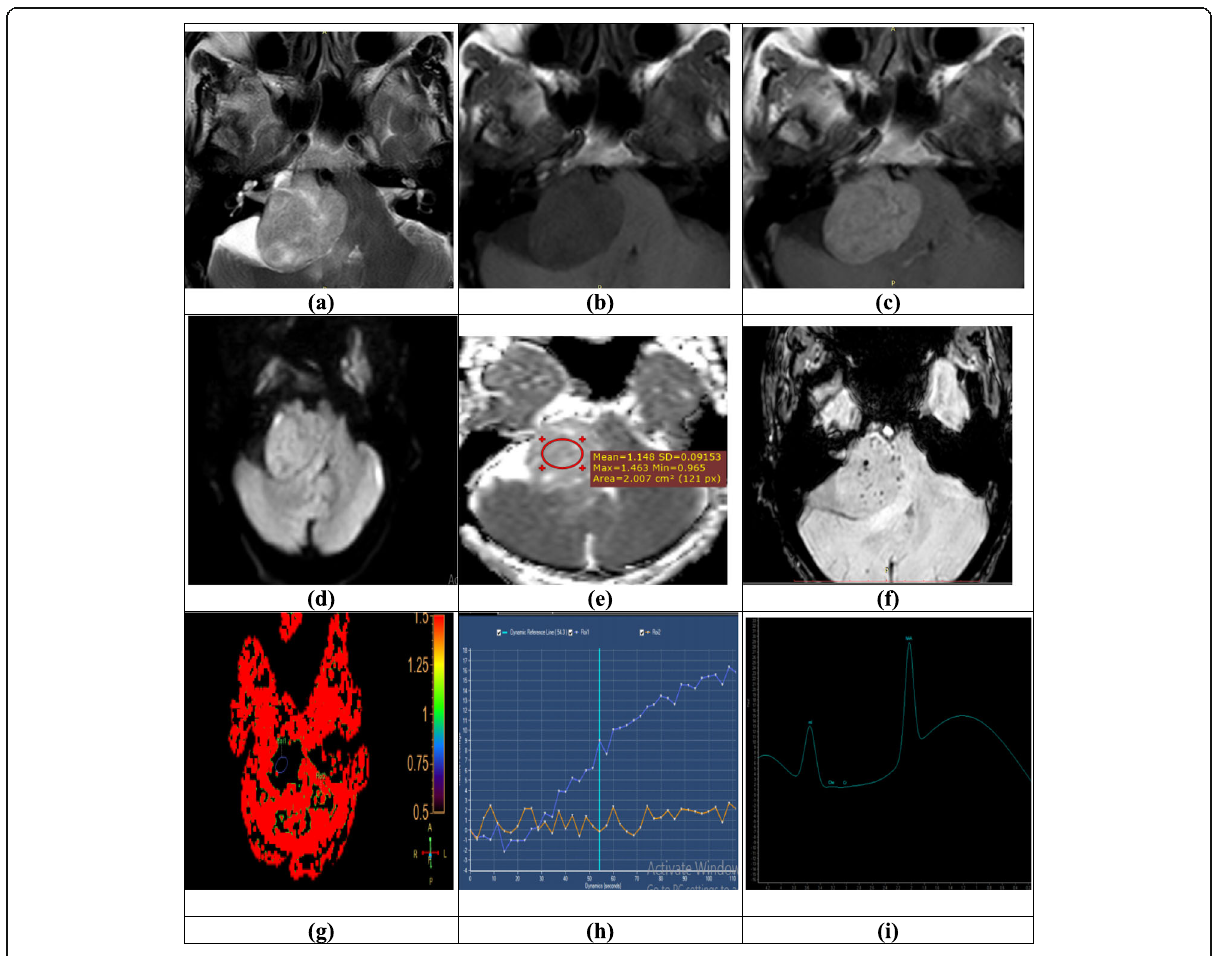
Fig. 2 A 60-years-old male presented with right sensorineural hearing loss. A right CPA space-occupying lesion is seen. This is hyperintense on T2WI ( a ), hypointense on T1WI ( b ), showing homogenous, solid and moderate post-contrast enhancement on T1WI+C ( c ), hyperintense on diffusion image ( d ) showing intermediate ADC value 1.14 × 10 − 3 mm 2 /s ( e ), signal voids on SWI ( f ), showing hypoperfusion in perfusion map ( g ) and hypoperfused curve on PWI ( h ), with myo-inositol peak on MRS ( i ). The findings were matching with the final diagnosis of the right CPA